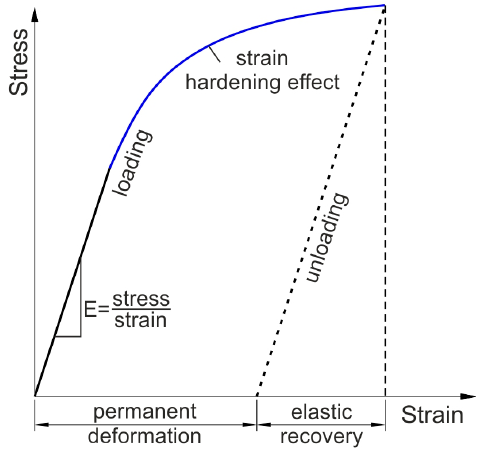
Figure 8. The bending characteristics of material.